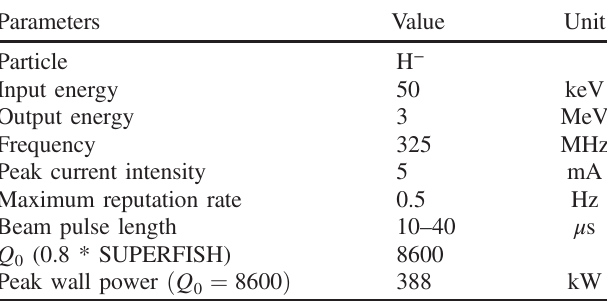
TABLE I. Main design parameters of XiPAF RFQ.